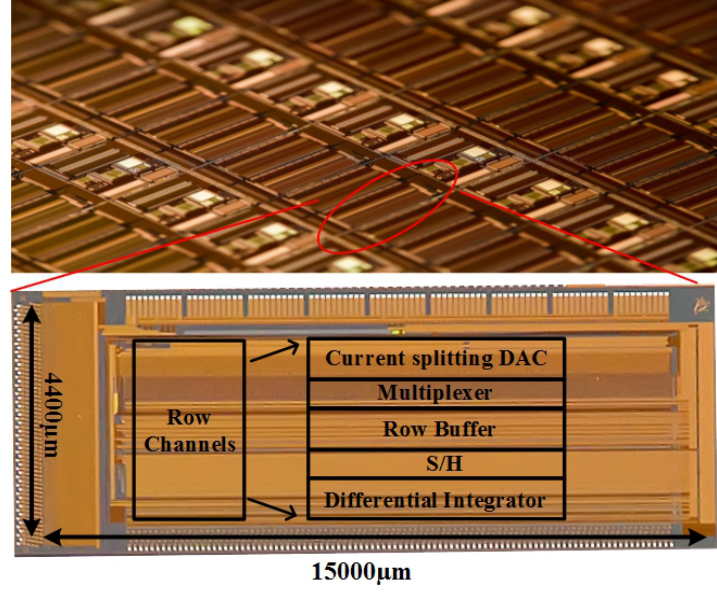
Figure 8. Microphotograph of designed